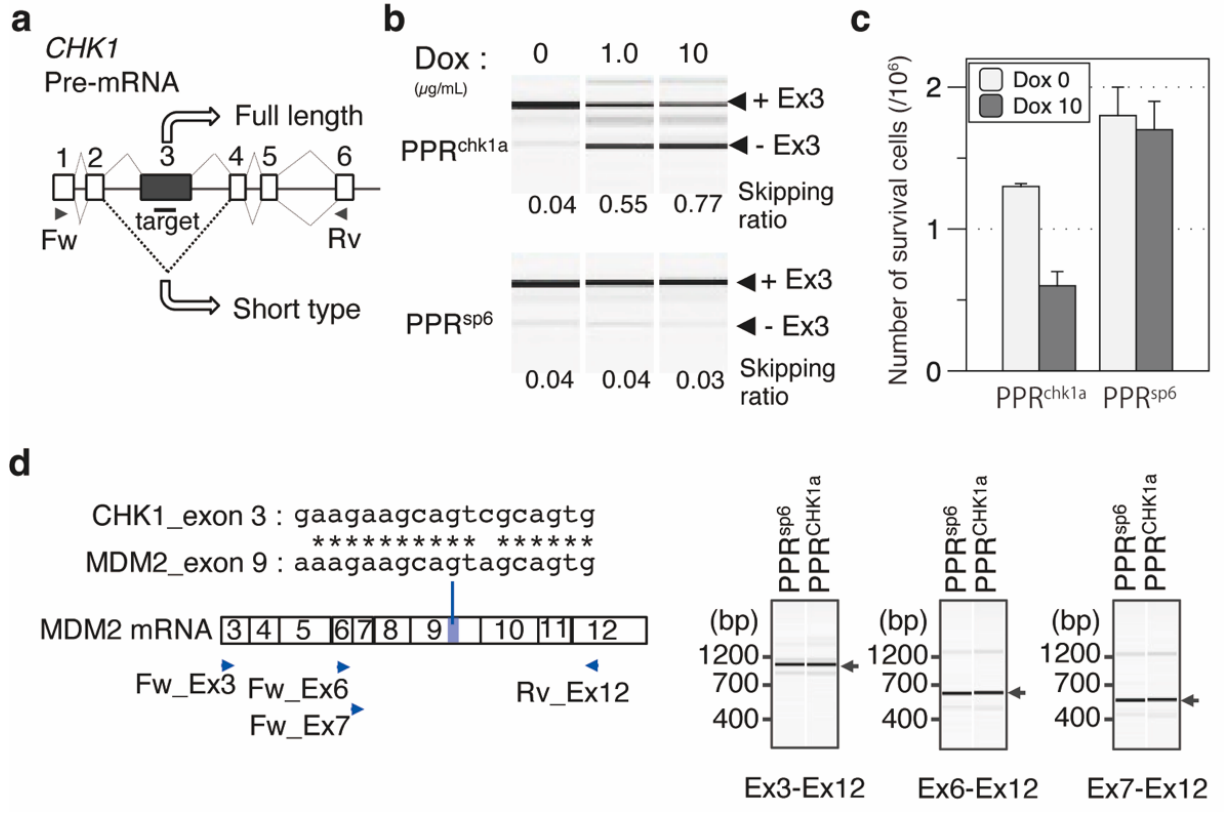
Figure 5. Designer PPR proteins induced exon skipping of CHK1 mRNA and the retardation of cell growth. ( a ) Exon–intron structure of CHK1 pre-mRNA. The target position was designed in exon 3 of the CHK1 gene. ( b ) RT-PCR analysis of exon skipping. The amount of the splicing variant with or without exon 3 (+Ex3 or − Ex3) was analyzed using Dox-induced expression of PPR chk1a . PPR sp6 was used as a negative control. The primer position used for RT-PCR is shown in ( a ). The skipping ratio was estimated by calculating the signal intensity of [ − Ex3]/([+Ex3] + [ − Ex3]). ( c ) Analysis of cell num- ber with or without the induction of the designer PPR genes (PPR chk1a or PPR sp6 ). Cell number was analyzed using trypan blue staining with the cells two days after dox induction (N = 3). ( d ) Off- target RNA analysis. Two mismatched chk1a sequences located in MDM2 exon 9. The exon was confirmed using RT-PCR with Ex3–Ex12, Ex6–Ex12, and Ex7–Ex12 primer sets. Primer positions are